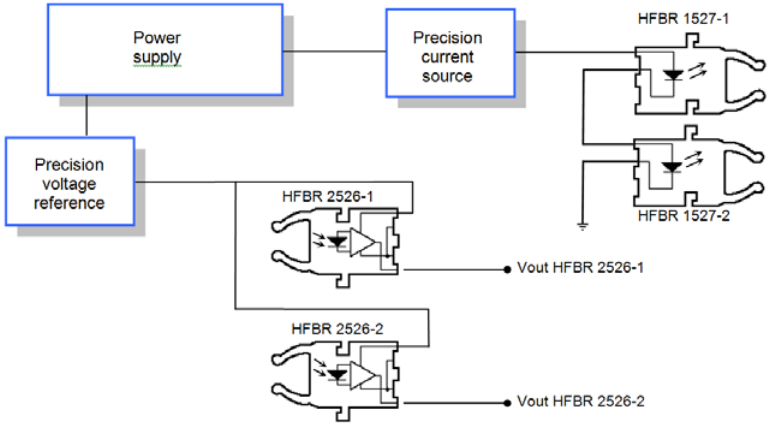
Figure 6. Electronic circuit block diagram with two emitter-receiver pairs, one for the sensitive fiber and another for the reference